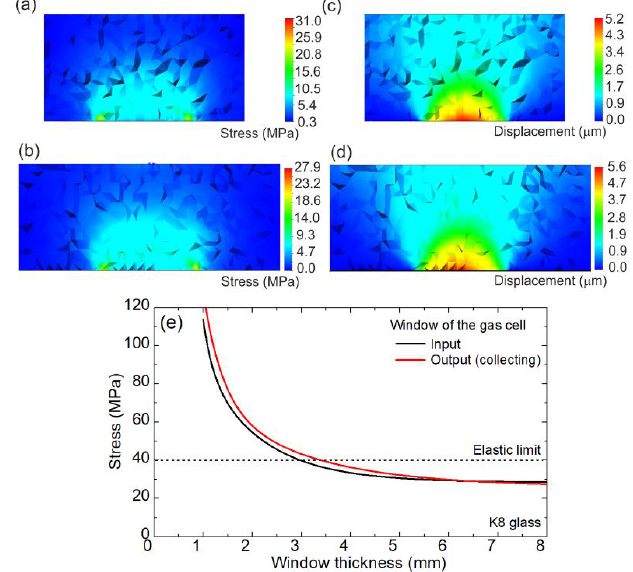
Figure 3. ( a – d ) Simulation of ( a , b ) the stress field, σ , and ( c , d ) the field of total displacements, u , in ( a , c ) the input window of the gas cell and ( b , d ) the output window used for collection of the scattered light. The gas pressure is 100 atm; ( e ) calculated maximum stress in the window vs. its thickness, the dashed line represents the elastic limit of the K8 glass (the window material). The grain structure in ( a – d ) represents the mesh used in the simulations.